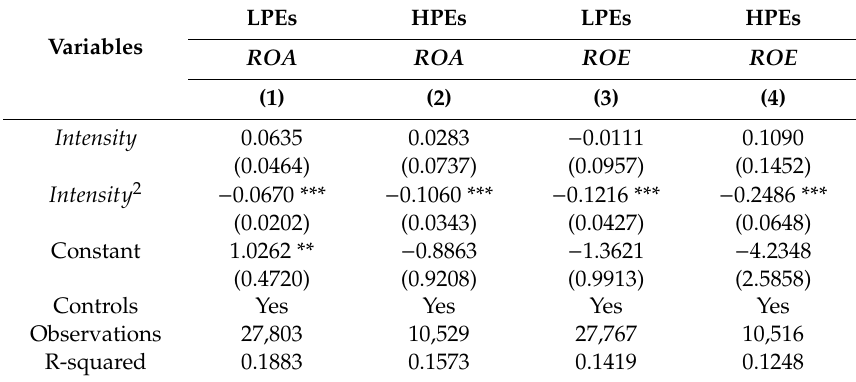
Table 7. The impact of ESI on the performance of HPEs and LPEs of